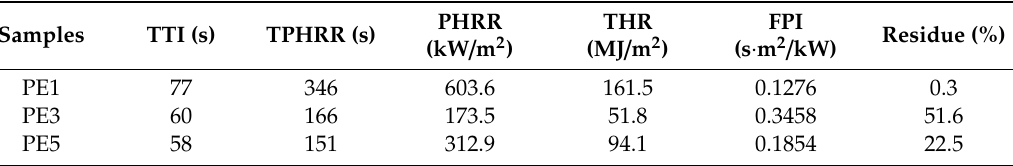
Characteristic parameters of the cone calorimetric test (CCT) for HDPE and HDPE / IFR